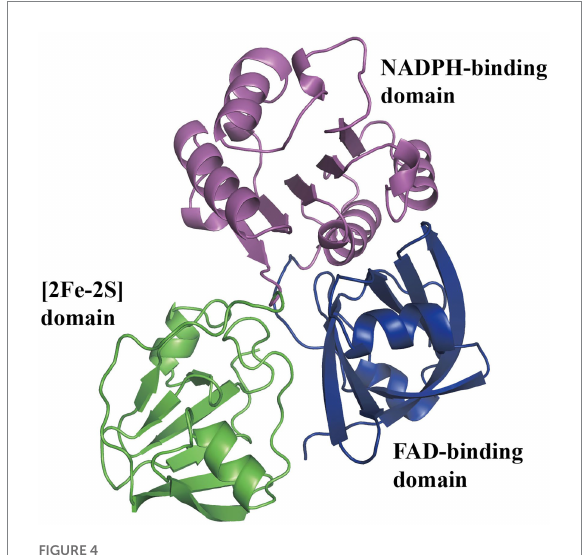
FIGURE 4 Predicted structure of PaaE. The overall predicted structure of EcoPaaE from AlphaFold. The PaaE is formed by three domains individually, N-terminal FAD-binding domain, NADPH-binding domain, and C-terminal [2Fe-2S] ferredoxin-like domain, shown in blue, magenta, and green,